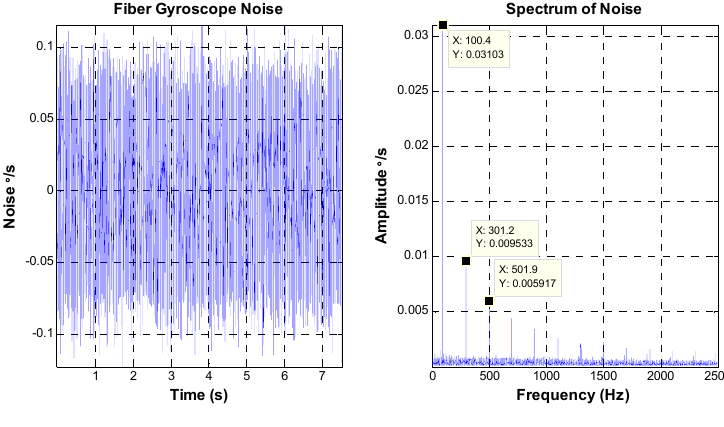
Figure 6. FOG noise characteristics.